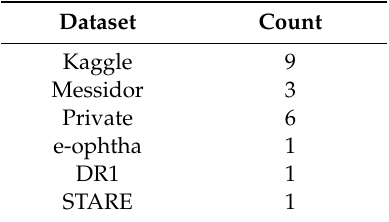
Table 5. Datasets